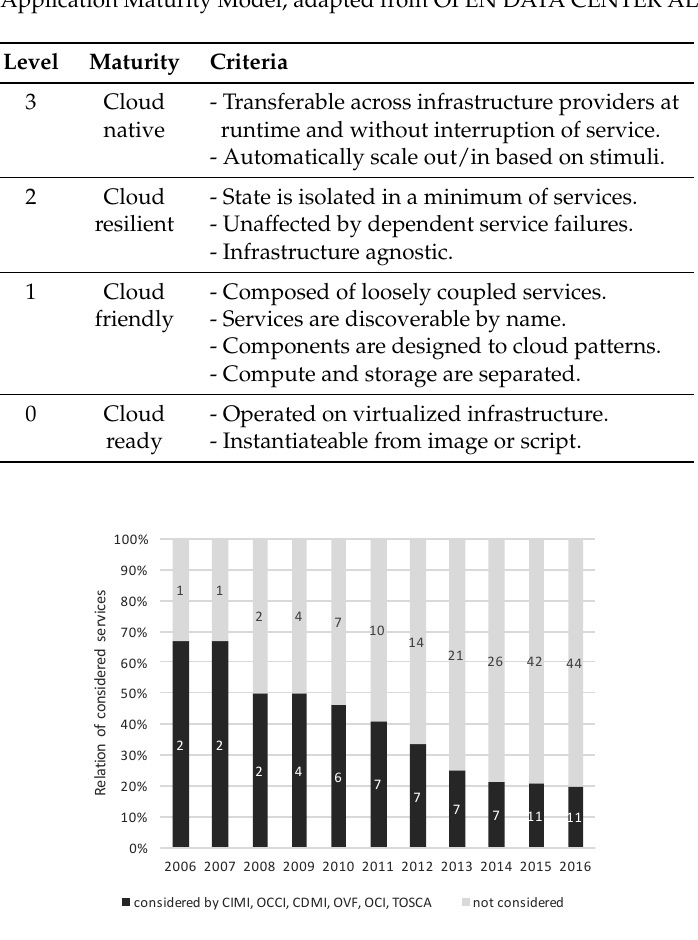
Table 1. Cloud Application Maturity Model, adapted from OPEN DATA CENTER ALLIANCE [22].